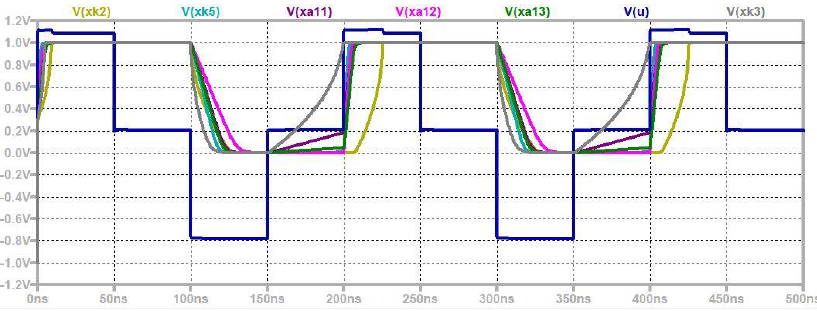
Figure 6. Time diagrams of the memristor voltage, memristance, and state variables according to the applied modified and standard metal-oxide memristor models.